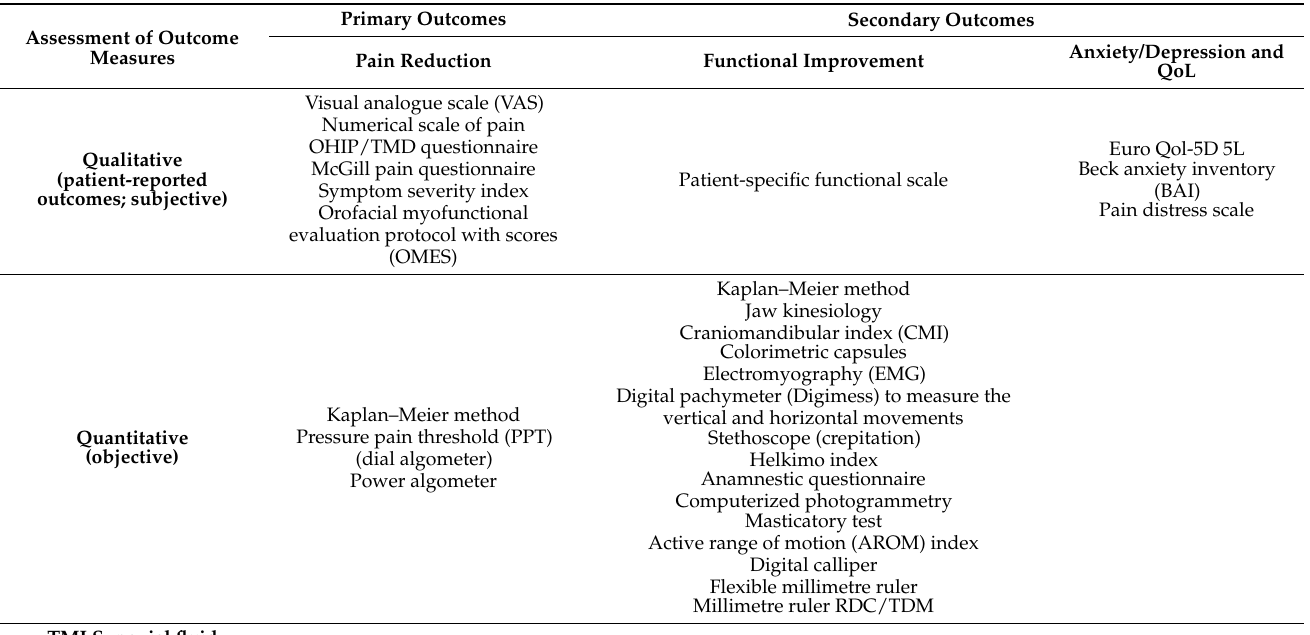
Table 1. The qualitative and quantitative measurements for primary and secondary outcomes utilised in the selected studies of this review, with consideration for TMJ synovial fluid analysis to evaluate the levels of oxidative stress, IL-1,6,8, TNF- α and β , MM-1,2,9, VEGF, TGF- β 1 and IGF-I, for future extensive research. All the abbreviations in this table are listed in Supplementary File